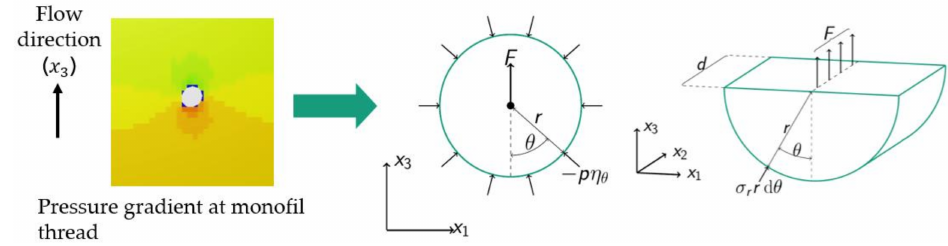
Figure 16. Restriction of applied pressure to beam